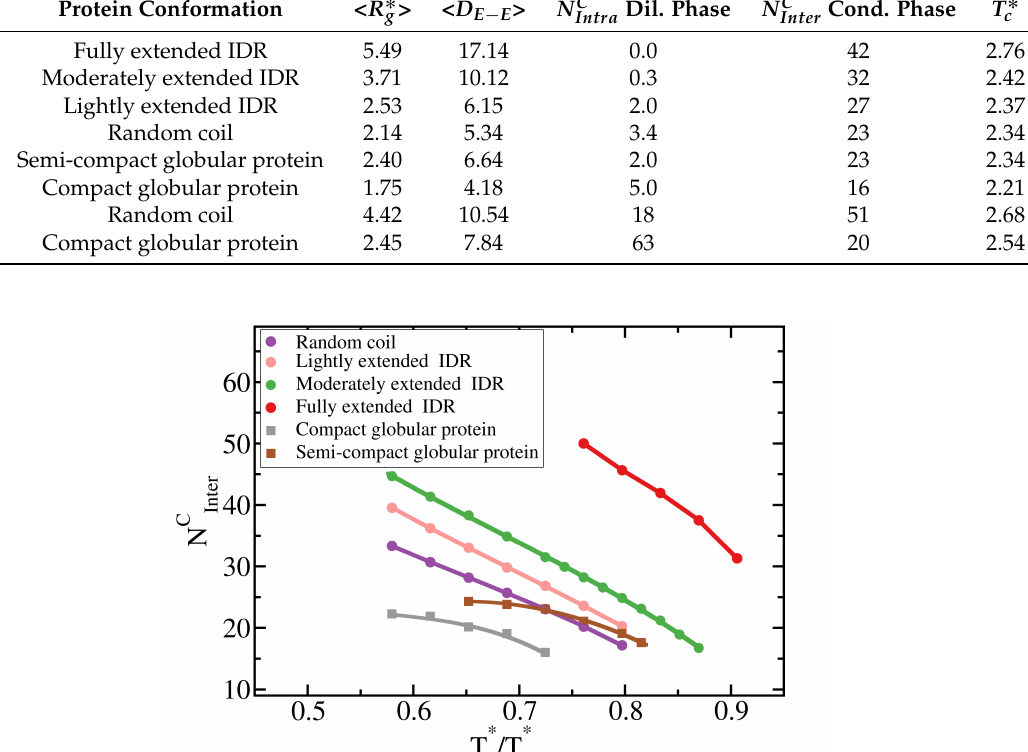
, as a function of T ˚ { T ˚ for the different 20-bead Inter c , FE